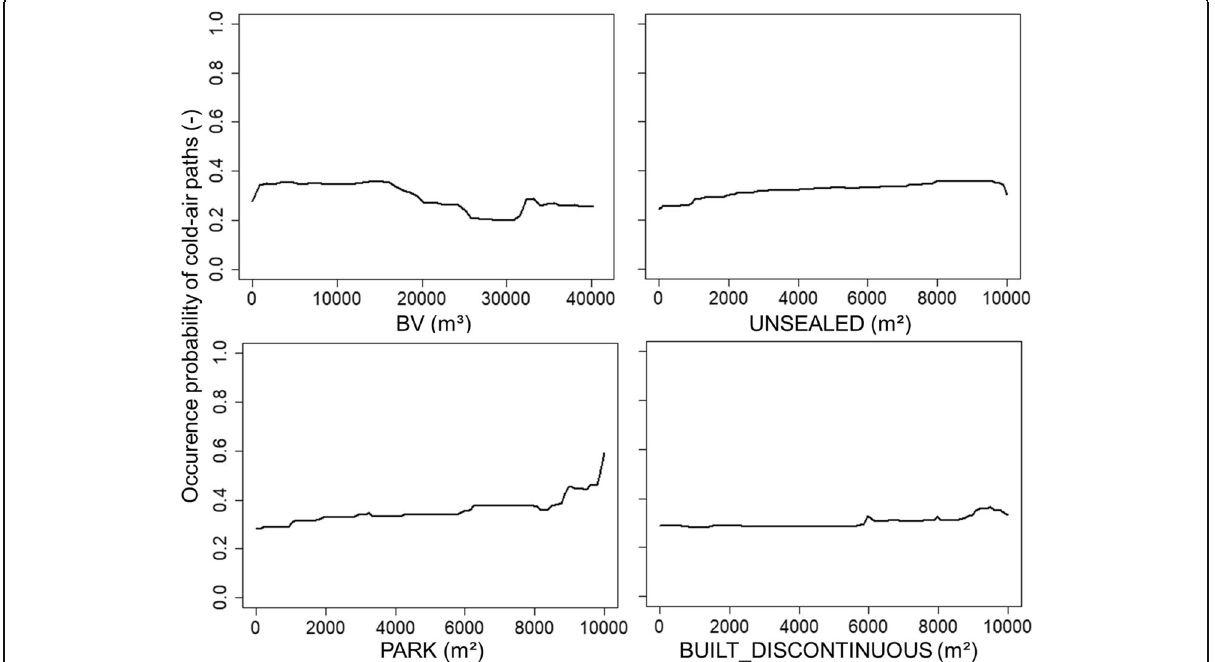
Fig. 3 Partial dependence plots (PDPs) of the variables used for land-use change